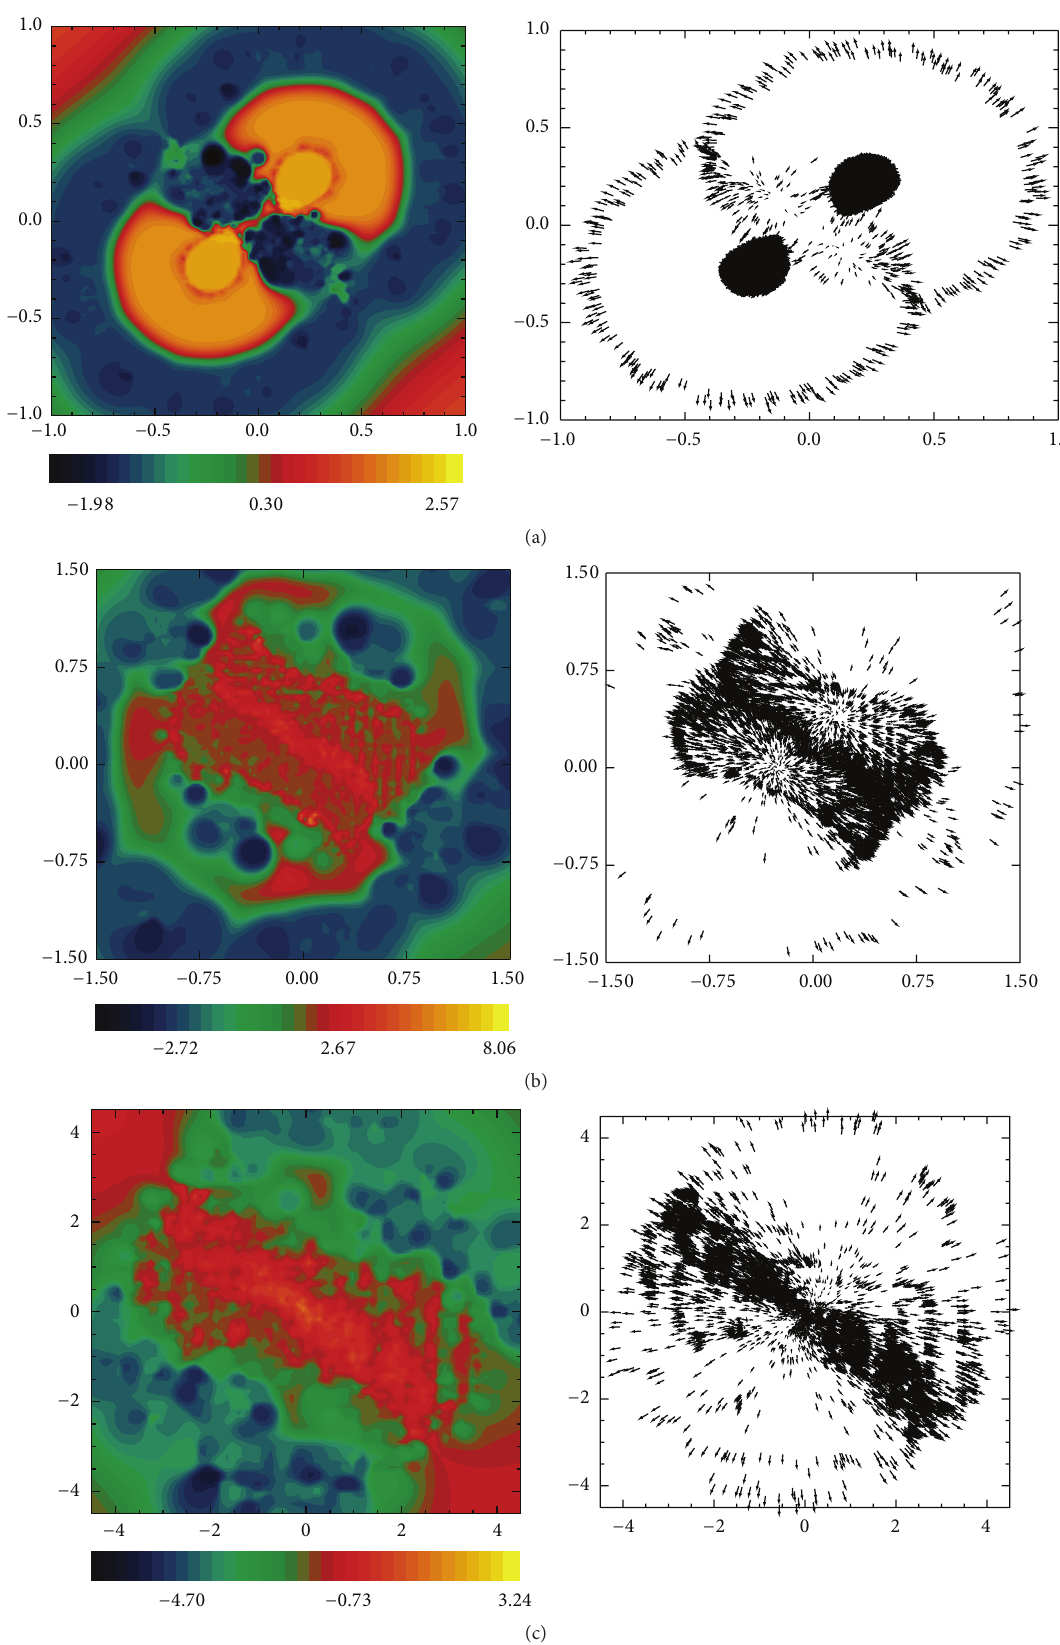
Figure 7: Iso-density plots for a binary system formed by the source A3 model at times (a) 5928 sec.; (b) 2.02×10 4 sec.; and (c) 6.66×10 4